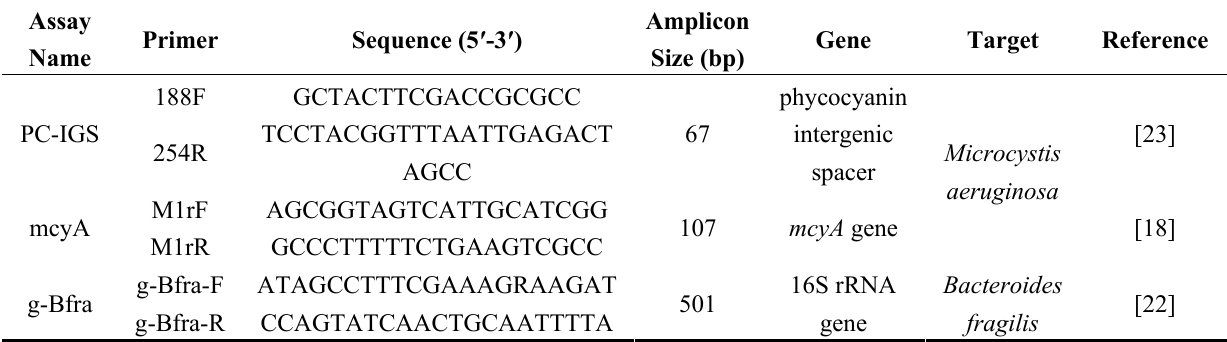
Table 1. Primers used in this